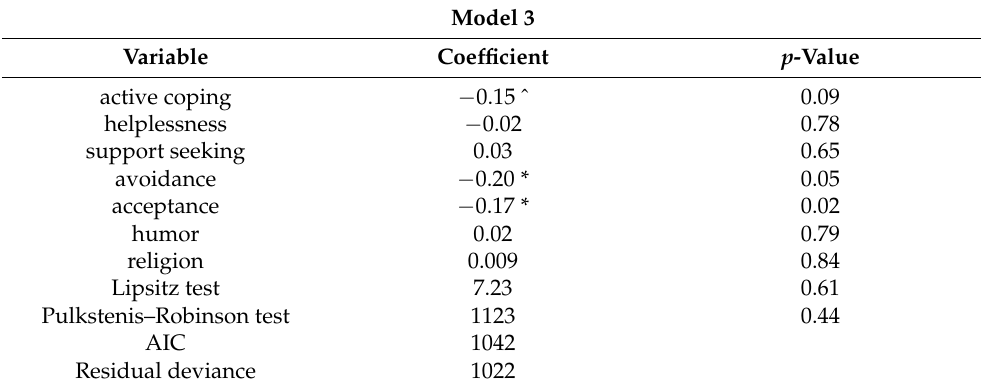
Table 5. Results of logistic